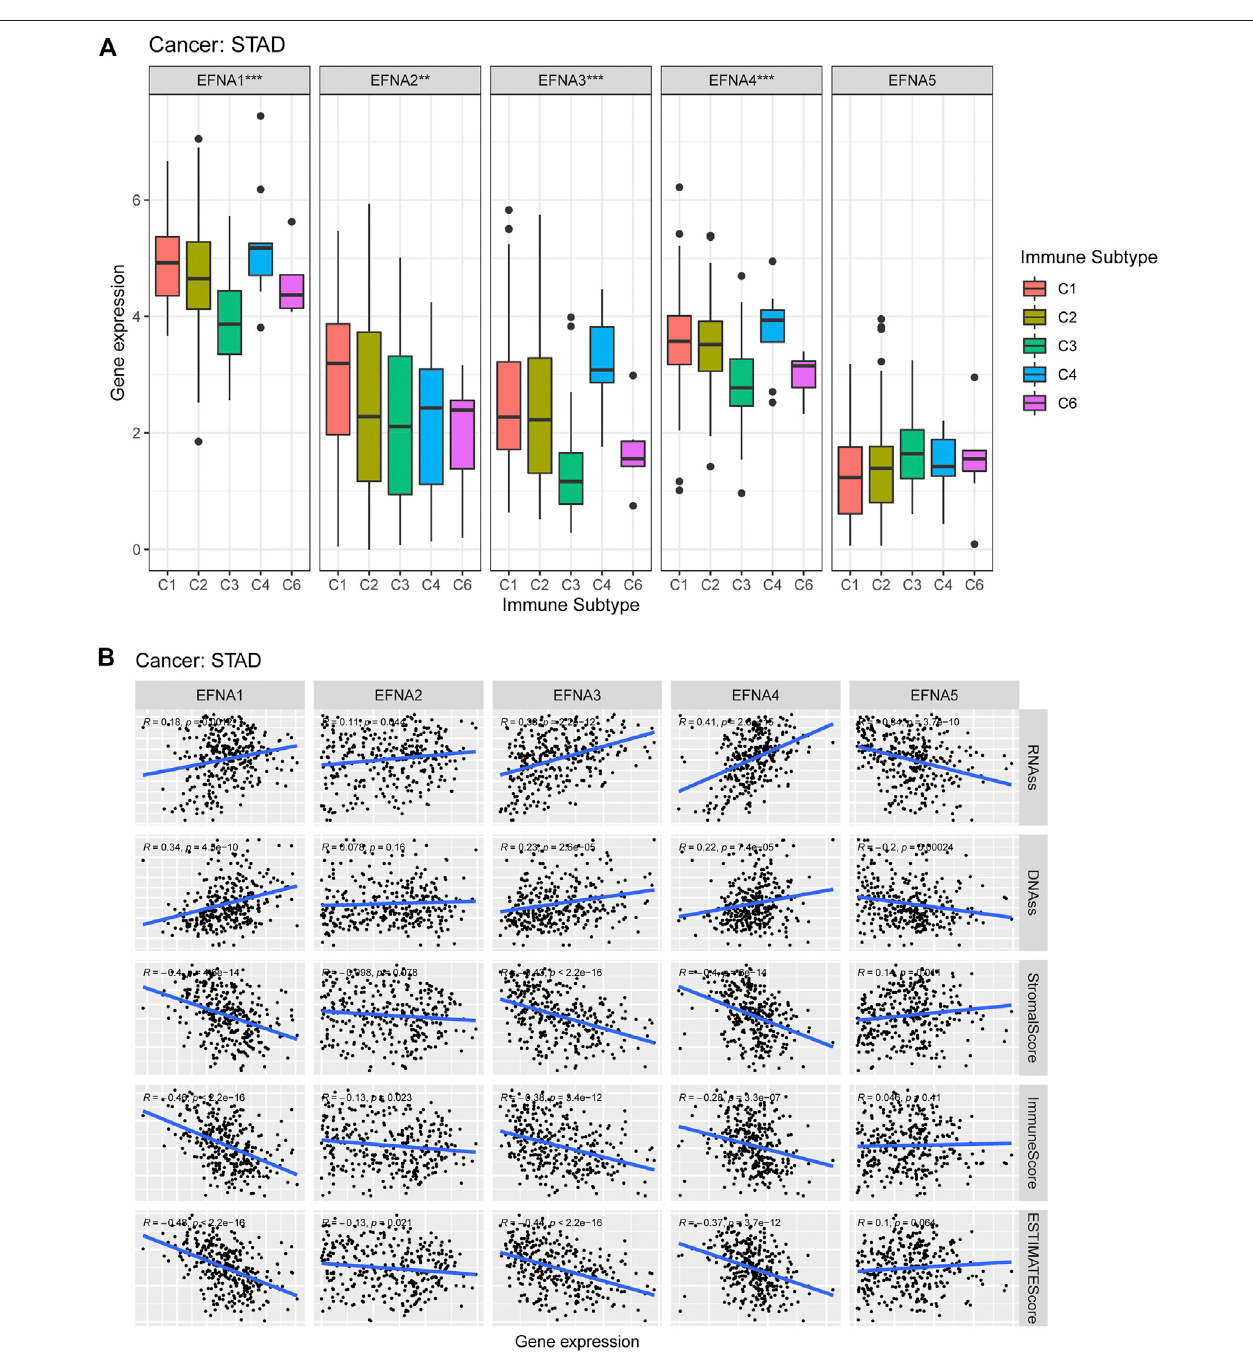
FIGURE7| Expressionof EFNA genesindifferentimmunesubtypes,aswellasitscorrelationwiththetumormicroenvironmentandstemcellindex. (A) Expression levelsof EFNA1-5 indifferentimmunesubtypesofgastriccancer. (B) Associationbetween EFNA1-5 expressionandRNA-ss,DNA-ss,StromalScore,ImmuneScoreand ESTIMATEScore in gastric